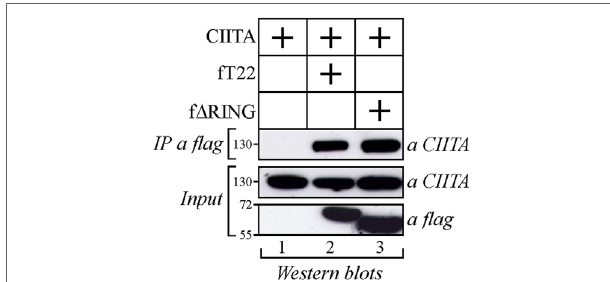
FigUre 1 | class ii transactivator (ciiTa) interacts with tripartite motif-containing protein 22 (TriM22) independent from the really interesting new gene (ring) domain . 293T cells were transfected with plasmid coding for myc-tagged CIITA alone or in combination with vectors expressing flag-tagged TRIM22 full-length (fT22) or TRIM22 RING mutant (f Δ RING). Cell extracts were immunoprecipitated (IP) with anti-flag monoclonal antibody (mAb) (IP a flag) and the IP complexes were analyzed by western blotting with anti-CIITA mAb. Ten percent of the whole cell extract was analyzed by Western blotting for the expression of TRIM22 full-length, its deletion mutant TRIM22- Δ RING and CIITA